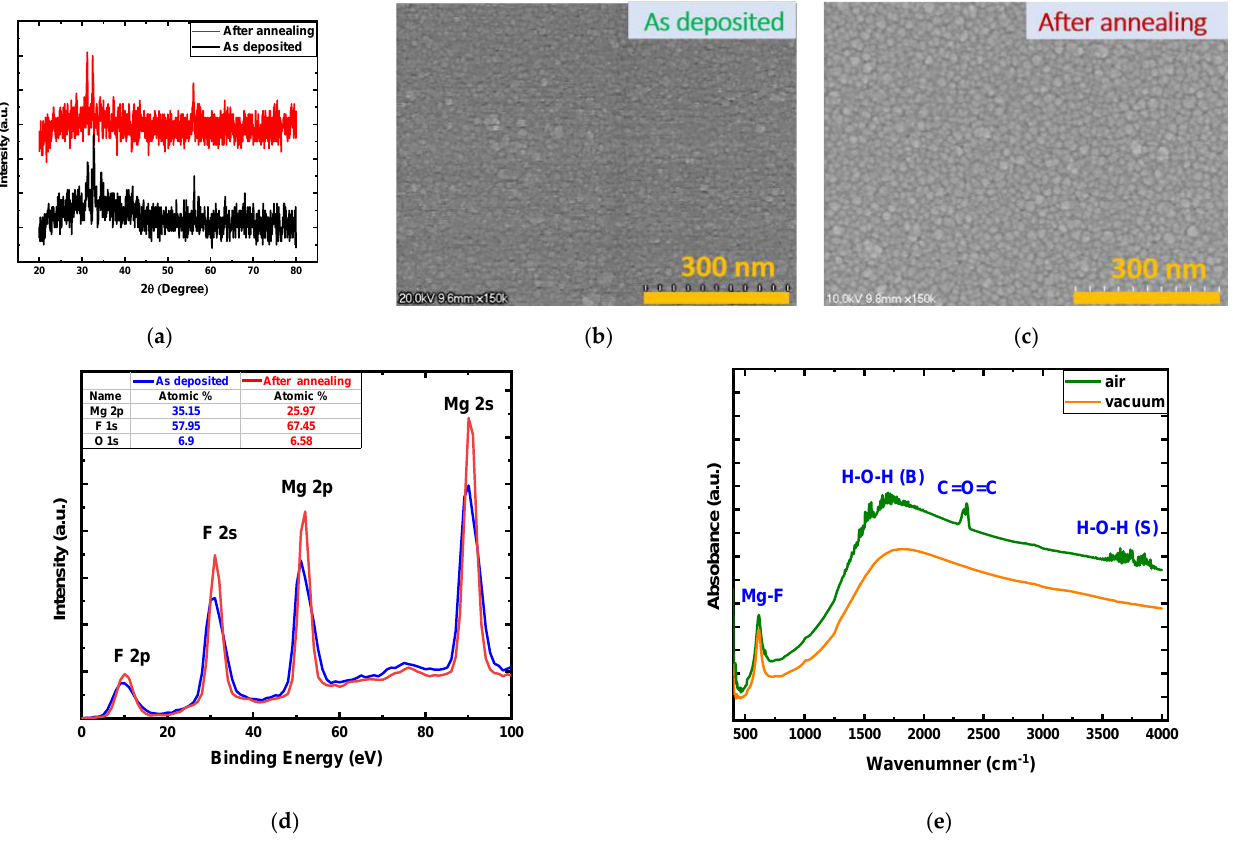
Figure 1. Structural and compositional analysis of MgF x thin film: ( a ) XRD pattern of the as− deposited and annealed MgF x films; SEM surface images of the ( b ) as− deposited and ( c ) annealed films; ( d ) XPS analysis with atomic percentages of the as-deposited and post-deposition annealed MgF x films; ( e ) FTIR absorbance spectra measured in open air and vacuum environment.